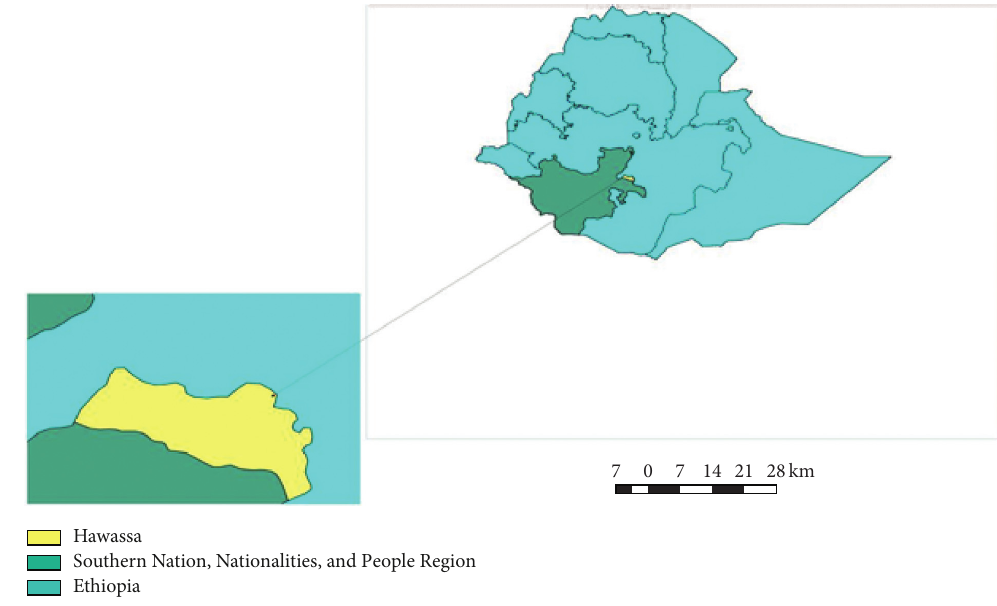
Figure 1: Geographical location map of Hawassa [23]. Table 1: Overall prevalence of GI helminth parasites in horses and donkeys. Animal species No. of examined